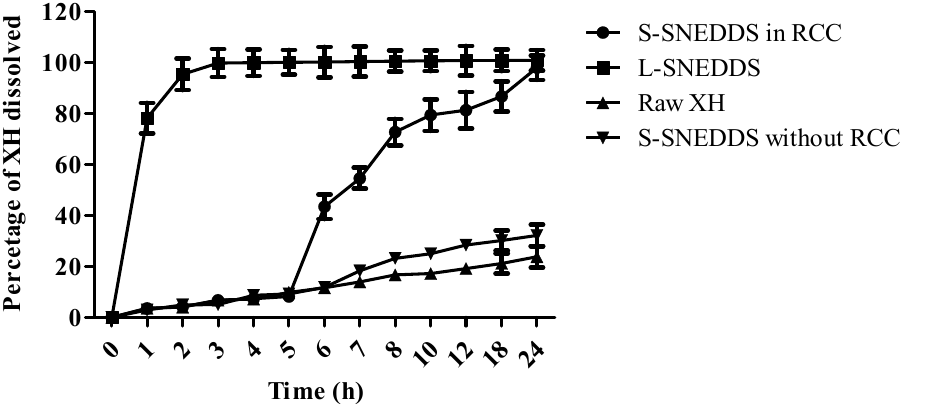
Figure 6. Results of dissolution studies (n = 6) for raw XH, L-SNEDDS, and S-SNEDDS in RCC and without RCC. RCC–Rat caecal contents (n = 6).